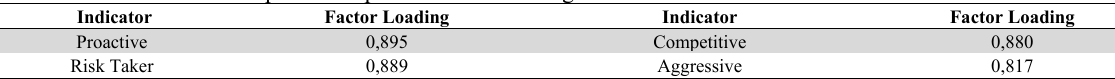
Factor Test Results for Entrepreneurship Orientation Loading Variables